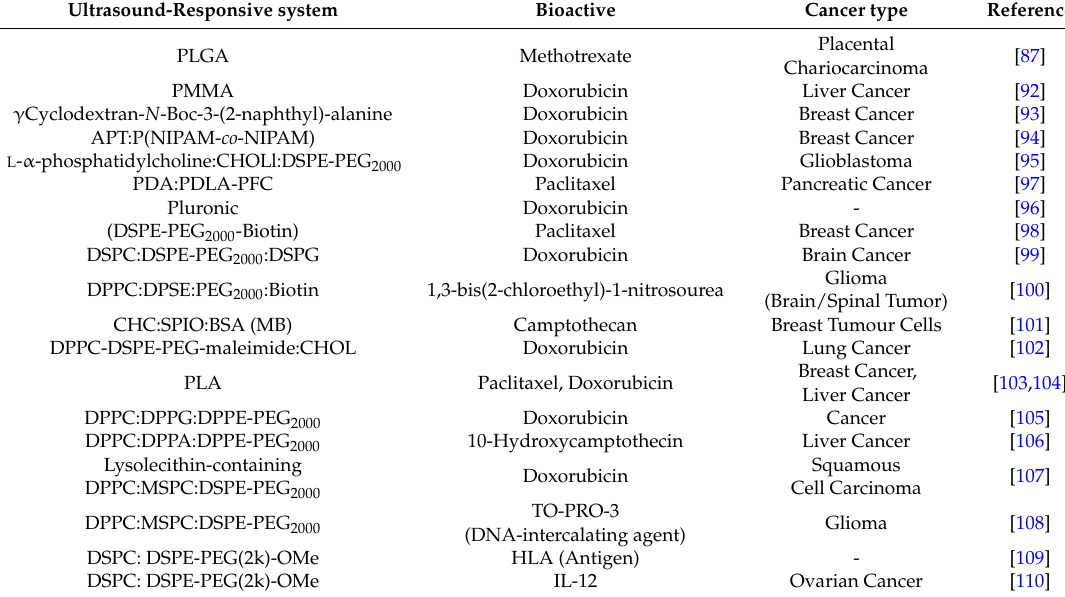
Table 2. Polymeric drug delivery systems responsive to ultrasound in cancer therapy. Ultrasound-Responsive